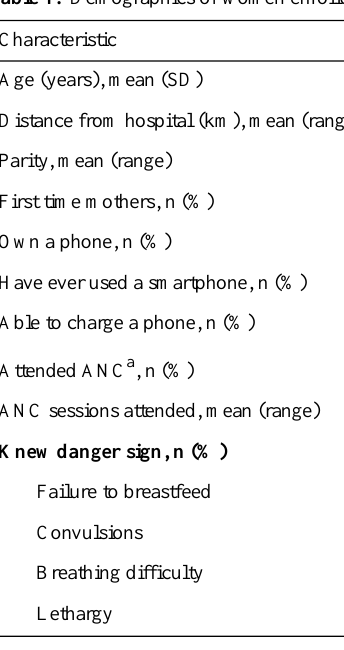
Table 1. Demographics of women enrolled in the study